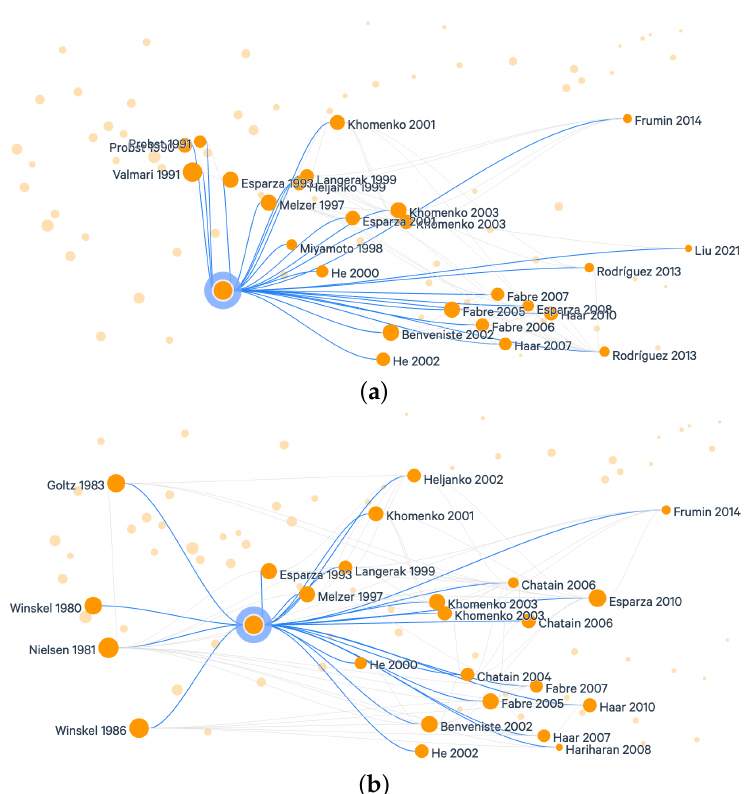
Figure 2. Litmaps representing the impact of both McMillan and Engelfriet studies on the partial- order models developed in the current decade (e.g., readers may refer to Tables 1 and 2 for more details). ( a ) McMillan’s unfolding impact on the current decade approaches. ( b ) Engelfriet’s Branching processes impact on the current decade